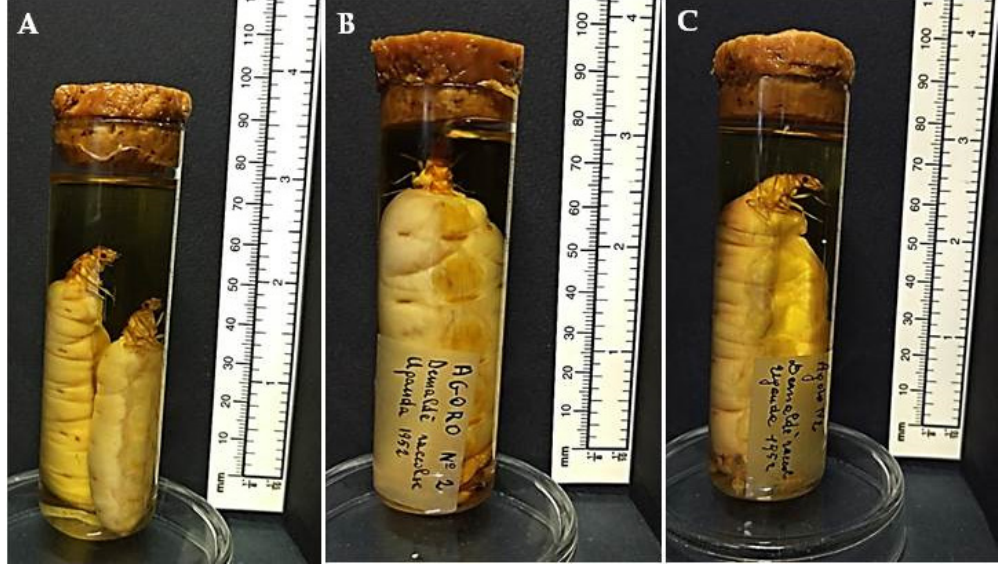
Figure 3. Examples of physogastric queens from Africa, respectively, contained in tubes V19-P03 ( A ), V19-P06 ( B ) and V19-P08 ( C ).